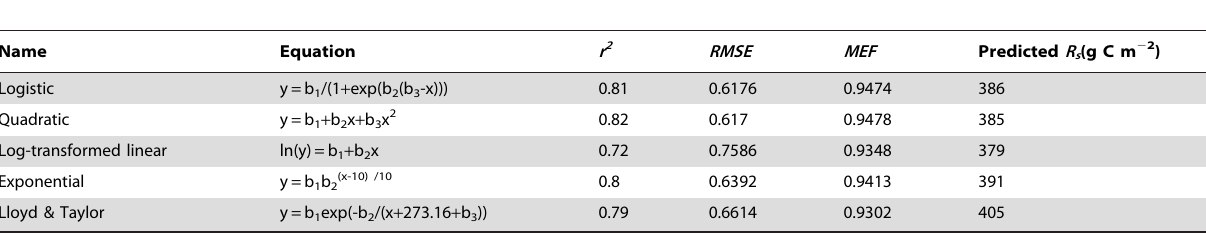
Table 1. Regression functions of soil respiration ( R s ) against soil temperature at 10 cm depth.